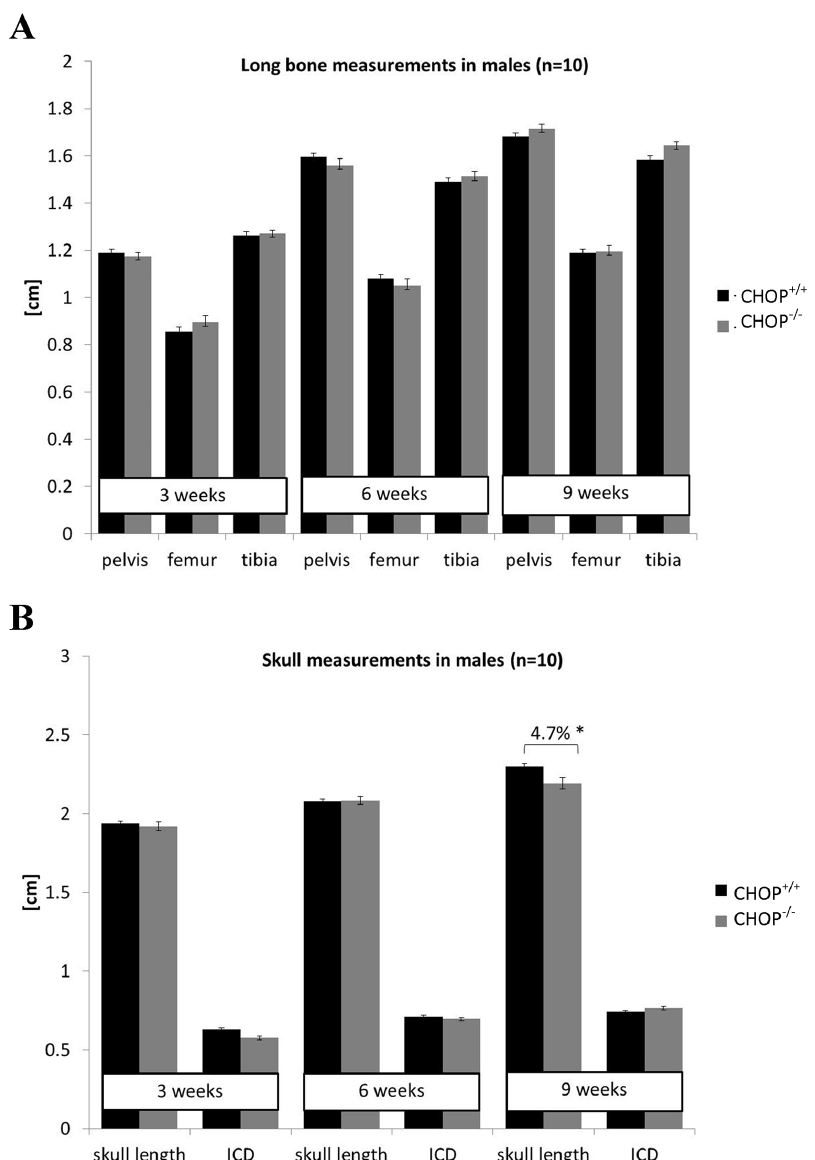
Figure 1. Bone measurements in mice lacking CHOP. A ) Long bone measurements (cm) of wild type and CHOP null mice at 3, 6 and 9 weeks of age confirming that deletion of CHOP had no effect on the long bone formation (n=10). B ) Head measurements (cm) in wild type and CHOP null mice demonstrating shorter skulls in CHOP null mice at 9 weeks of age (n=10; One Way ANOVA). Key: ICD=inner canthal distance; CHOP + / + =wild type, CHOP 2 / 2 =knock-out. Error bars show standard error of the mean (SEM); * P ,